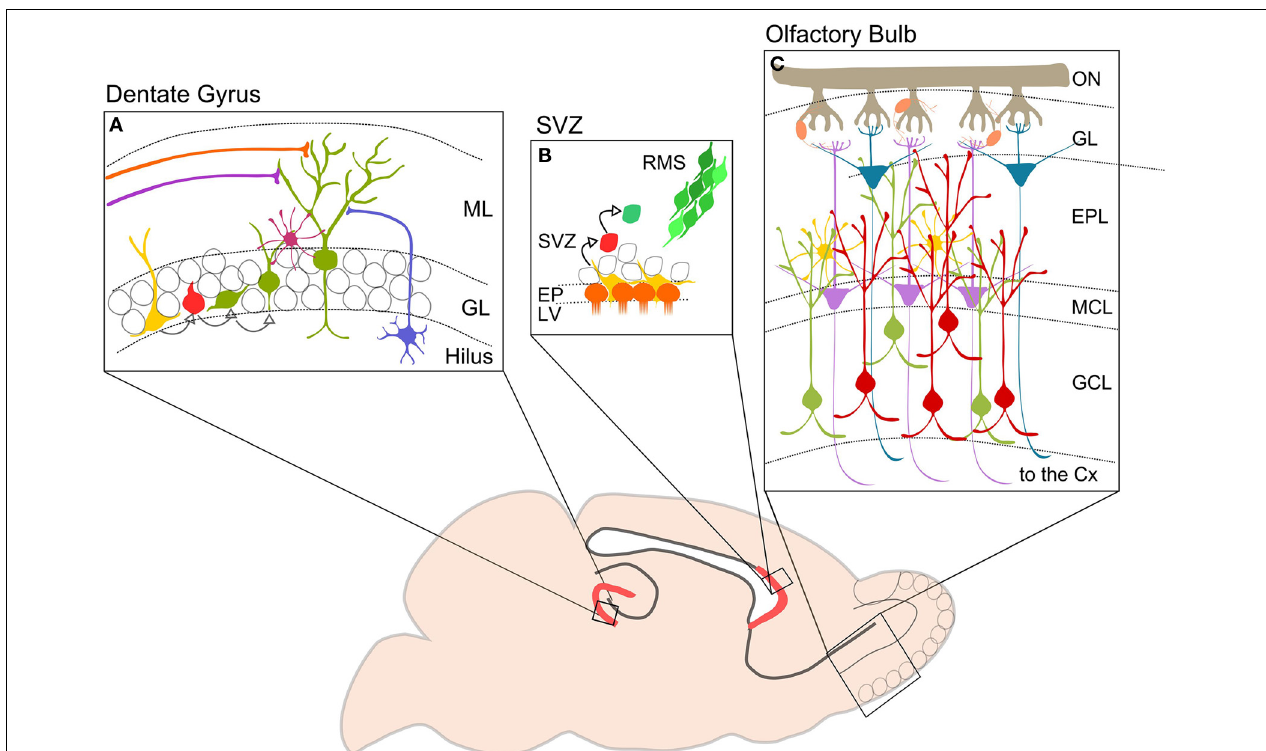
FIGURE 1 | Neurogenesisintheadultmousebrain. Thepictureshowsinred the two neurogenerative niches: (A) DG of the hippocampus. Type I cells (yellow) divide to generate type II cells (red) that differentiate in immature neurons (green). DG-GCs receive GABAergic inputs from hilar interneurons (blue) and basket cells (purple), and glutamatergic inputs from lateral and medial perforant pathways (orange and violet). (B) SVZ. Neurogenic niche contains progenitor or type B cells (yellow) close to the ependymal cells (orange). Type b cells dived slowly and give birth to type C cells (red) which divide again in neuroblasts or type A (green). Neuroblasts migrate in chains along the RMS (from Wang and Kriegstein, 2009 modified). (C) Schematic